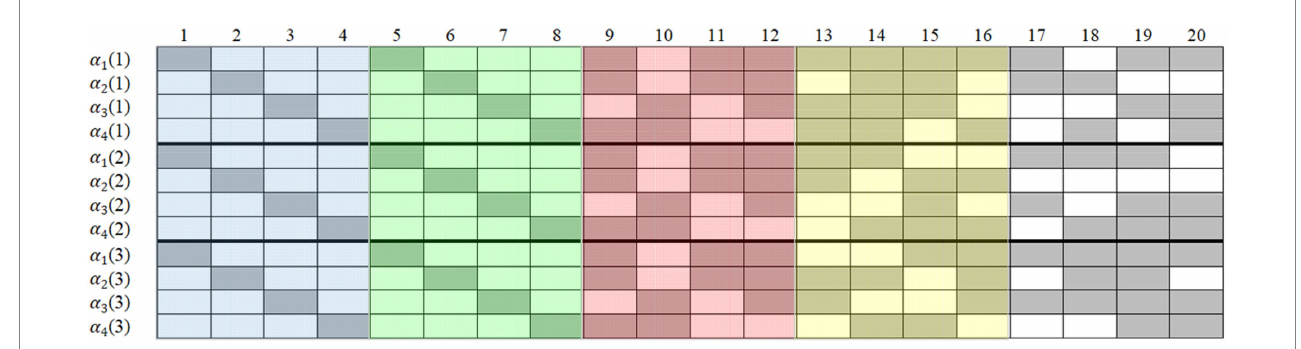
FIGURE 1 Sample Q-matrices with 20 items in Study 1. Gray means “1” and blank means “0”; occasion is in parentheses; simulated condition 1 contains anchor-items in the red area; simulated condition 2 contains anchor-items in the blue area; simulated condition 3 contains anchor-items in the red and yellow areas; simulated condition 4 contains anchor-items in the blue and red areas; simulated condition 5 contains anchor-items in the blue and green